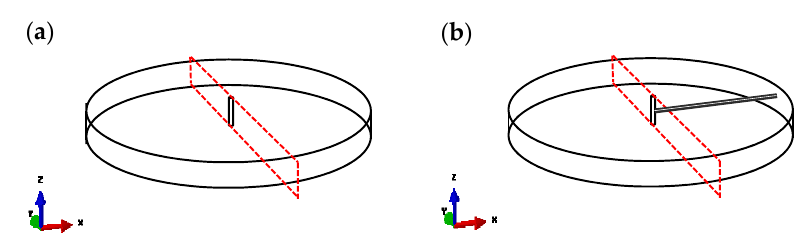
Figure 3. Wireframe view: ( a ) A model without radial well and ( b ) B model with the single radial well.